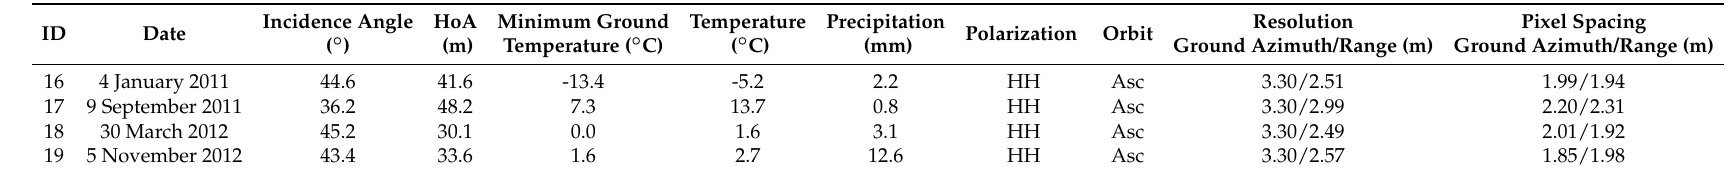
Table 2. The list of bistatic TanDEM-X stripmap acquisitions over the Peipsiveere test